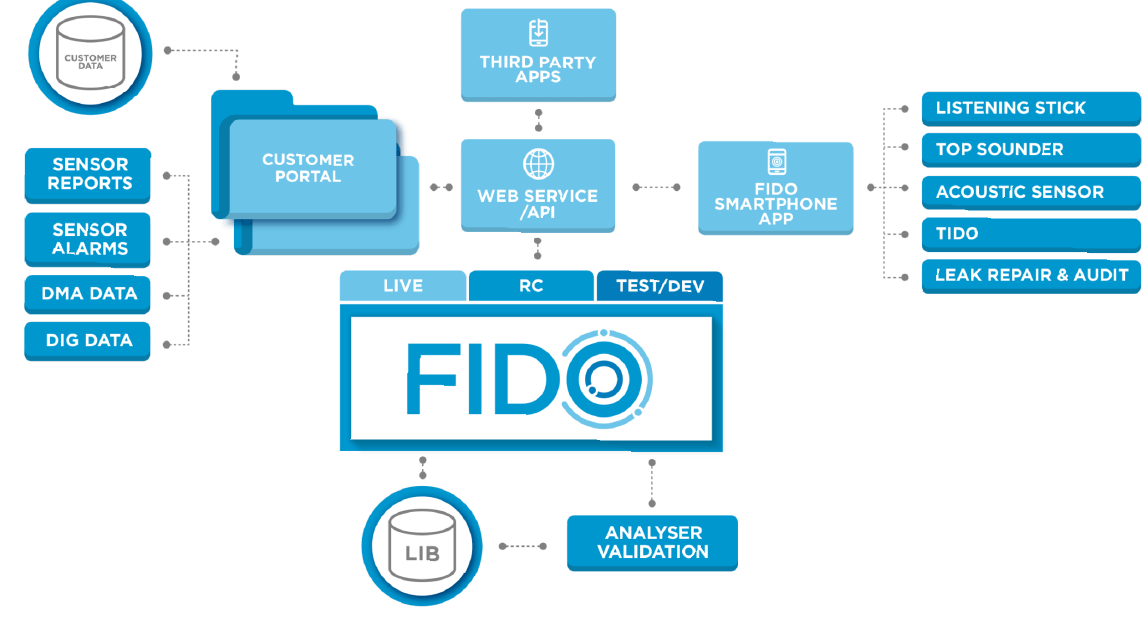
Figure 5: Structure of the FIDO system [Fido-Tech,